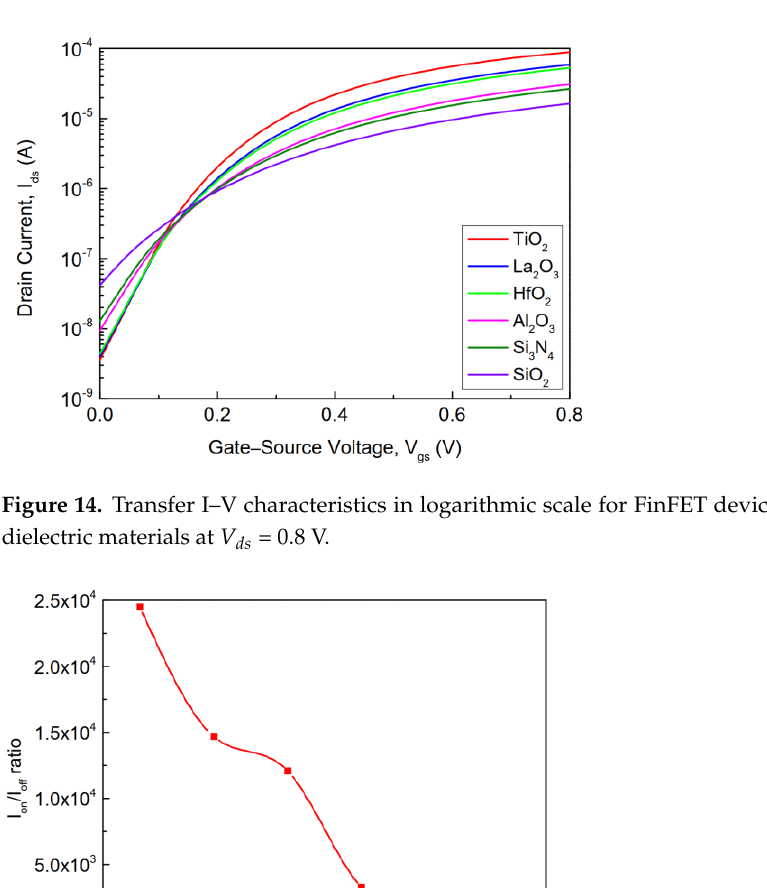
10 of 16 Figure 13. Behavior of ( a ) transconductance and ( b ) cut-off frequency with different high-k gate dielectric materials at V ds = 0.05 V. In short channel devices, the leakage current can be problematic for switching speed in the circuit by leading to an increase in the I on / I off ratio. The use of a multigate design structure together with high-k dielectric materials proves good mitigation in device issues and demonstrates high switching speed in electric circuits [16 – 22]. Figure 14 shows the transfer I – V characteristics in a logarithmic scale of 14-nm SOI n-FinFET under on-state bias conditions ( V ds = 0.8 V). It is observed that the off-state current decreases, especially